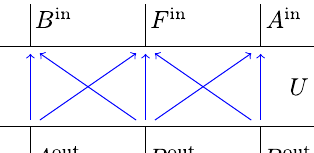
Fig. 6 Unitary map U that de fi nes the quantum SWITCH. The causal structure of U is indicated in blue.